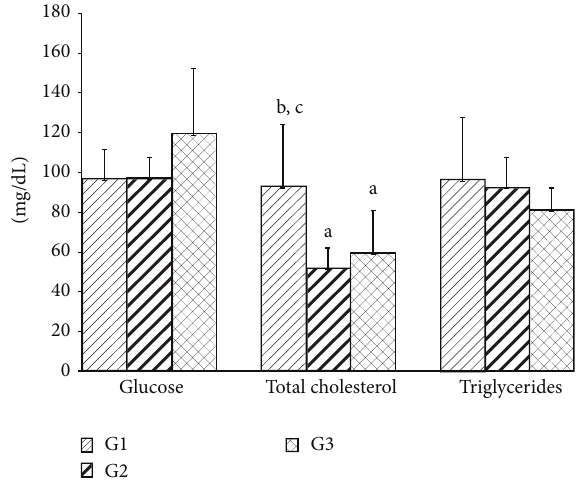
Figure 1: Serum glucose, total cholesterol, and triglycerides levels after 30 days for all experimental groups. Values are given as the mean ± SD for each group of eight animals. a Significantly different from G1; 𝑃 ≤ 0.05 ; b significantly different from G2; 𝑃 ≤ 0.05 ; and c significantly different from G3; 𝑃 ≤ 0.05 . G1: untreated control; G2: treated with geraniol; and G3: treated with essential